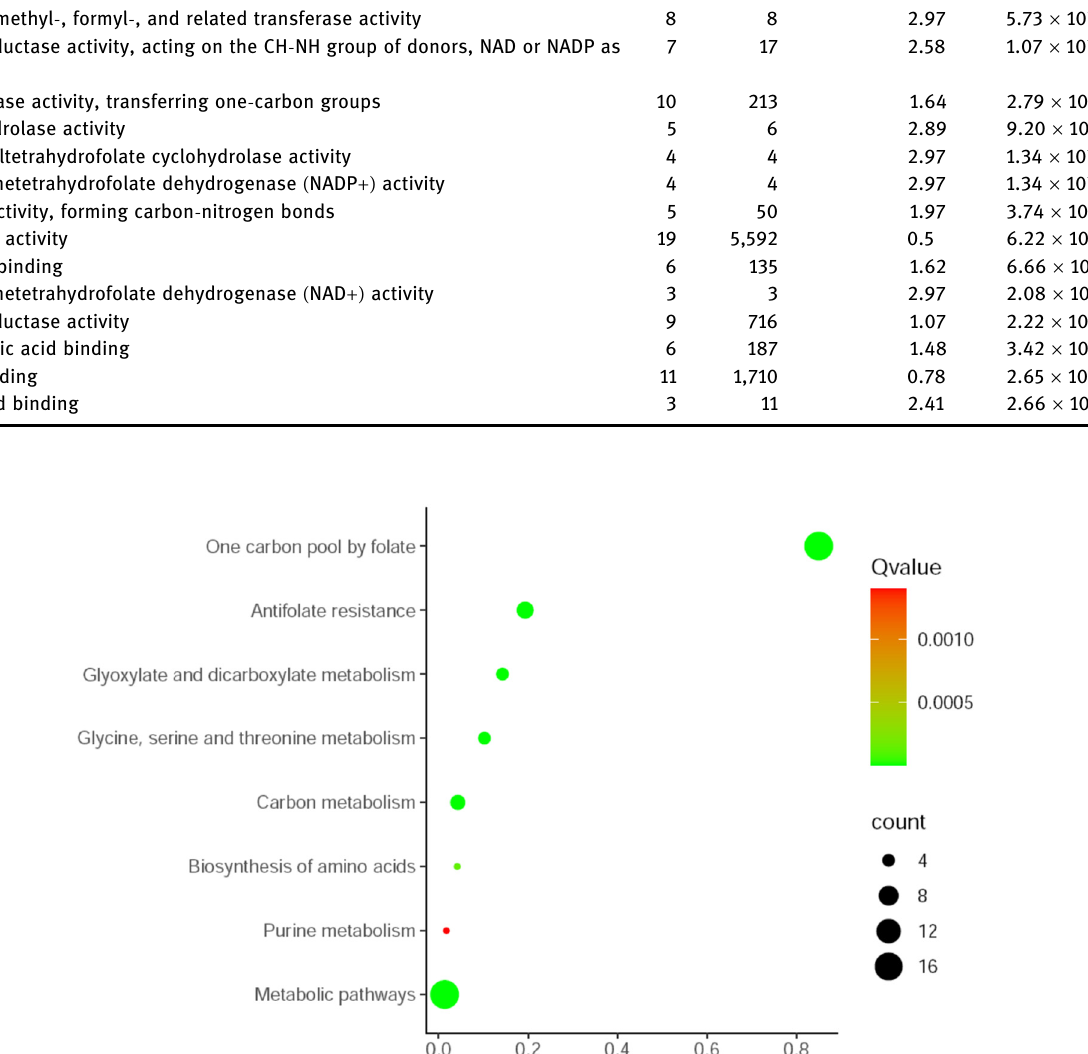
Table 3: MF enrichment for MTHFD2 and PPI network involved genes Term description